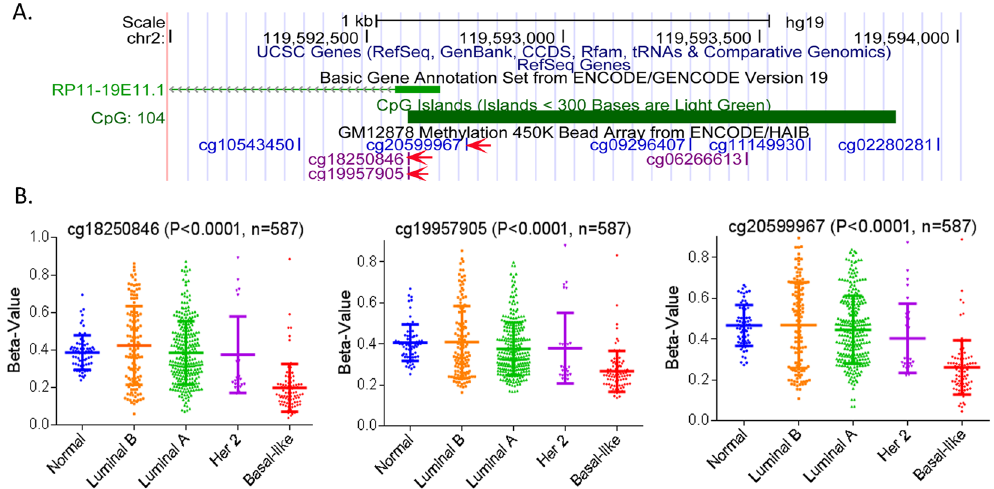
Figure 4. Hypomethylation of the BLAT1 Promoter in Basal-like Breast Tumors. ( A ) BLAT1 has 104 CpG sites in the promoter region. Three CpG sites (cg18250846, cg19957905, and cg20599967), which are located closest to the transcription start site, were selected for analyses. ( B ) Analysis of TCGA HumanMethylation450 Array data showed significantly lower methylation in the CpG sites in basal-like breast cancer (BLBC) tumors compared to normal breast tissues and other subtype breast tumors (p < 0.001). Beta values (0 to 1) are relative values increasing from hypomethylation to